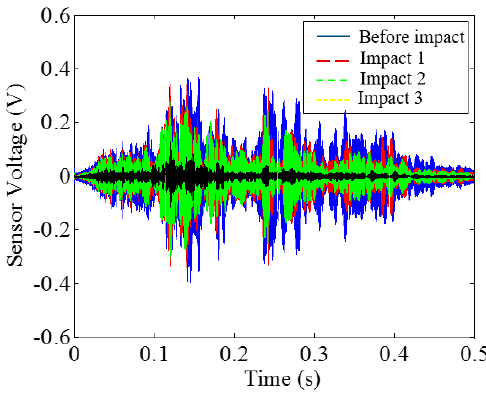
Figure 17. Time-domain signal received by SA sensor in PVA-ECC-3. Figure 17 . Time-domain signal received by SA sensor in PVA-ECC-3. Figure 17 . Time-domain signal received by SA sensor in PVA-ECC-3. Figure 17 . Time-domain signal received by SA sensor in PVA-ECC-3.